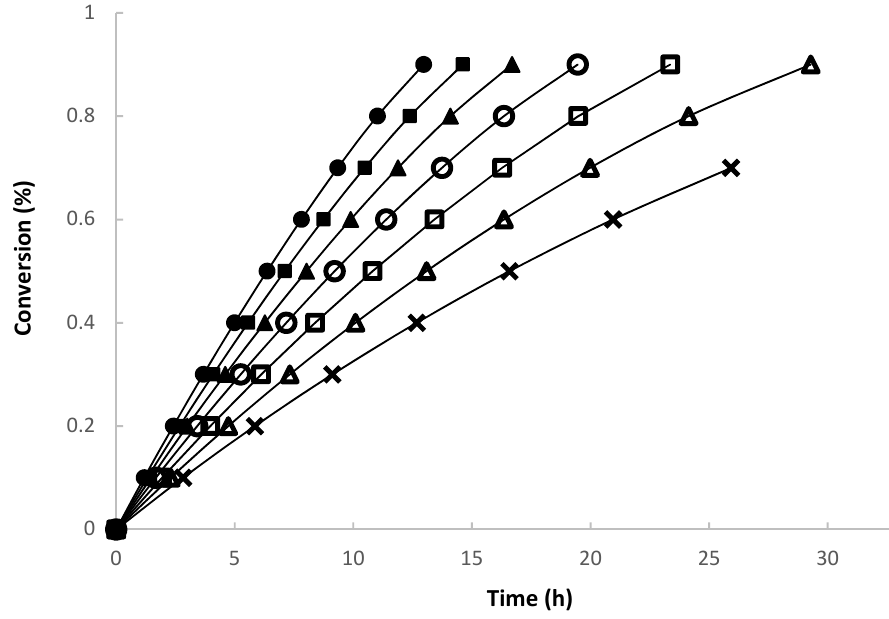
Figure 6. Operation of the enzymatic reactor by sequential batches with reactivation and monophasic first-order inactivation kinetics, k d = 0.02 h–1 and k r = 0.1 h –1 . ( ● ) Batch 1; ( ■ ) Batch 2; ( ▲ ) Batch 3; ( ○ ) Batch 4; ( □ ) Batch 5; ( ∆ ) Batch 6; (x) Batch 7.